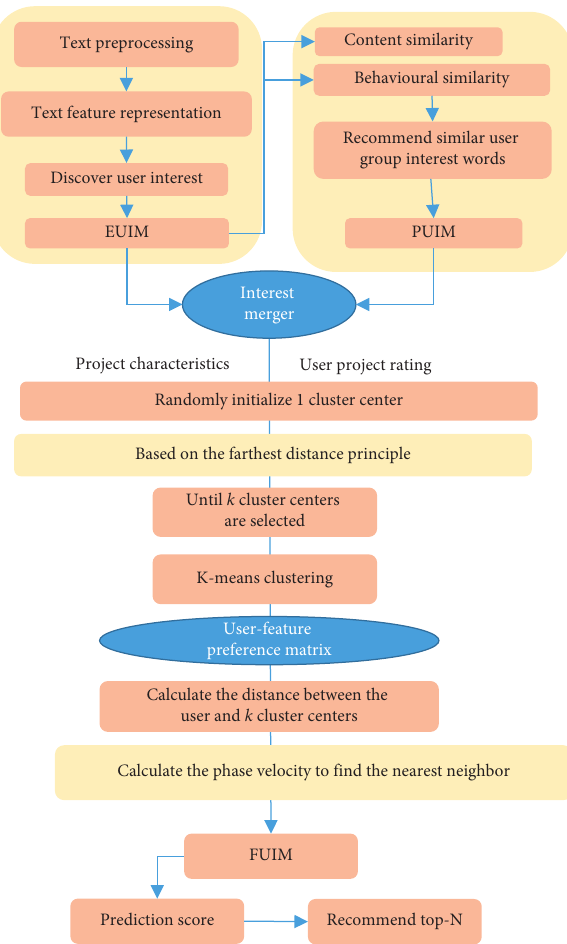
Figure 3: Flow chart of the recommended